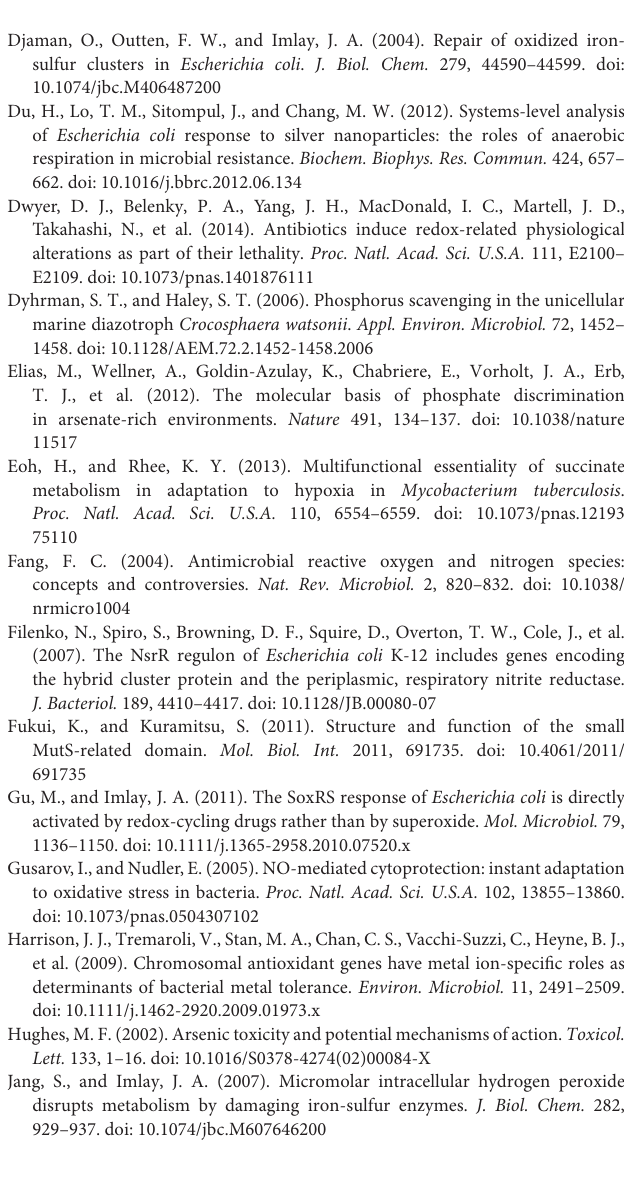
FIGURE S1 | Growth rates of LSJC7 under 4 mM As(V) stress. The arrows represent the sampling time for transcriptome, and the boxes represent the sampling time for As species